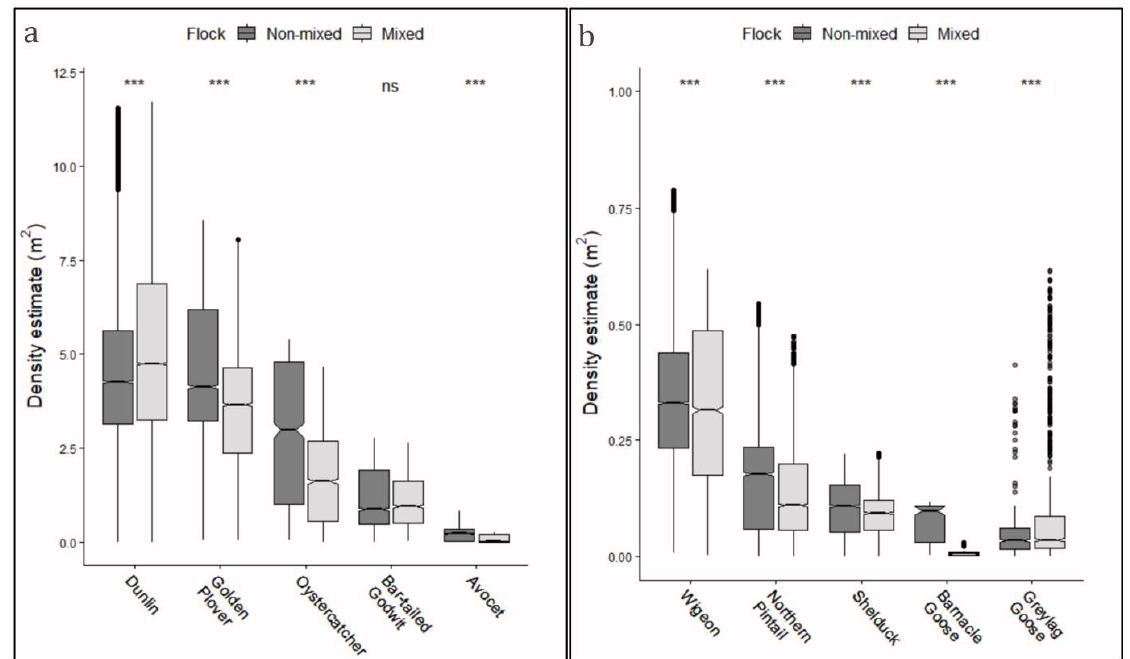
Figure 6. Densities for mixed (multi-species) and non-mixed (single species) flocks of roosting waterbirds, shown by boxplots. Densities were pooled for all individuals observed on both field days (27 Sep. and 23 Oct.). ( a ) Boxplots for density distributions for the investigated species of waders, and ( b ) boxplots for density distributions for the investigated species of ducks and geese. Differences between mixed and non-mixed flocks were tested with Wilcoxon test for matched pairs, and significance levels are depicted above each group (ns = nonsignificant, “***” < 0.001).